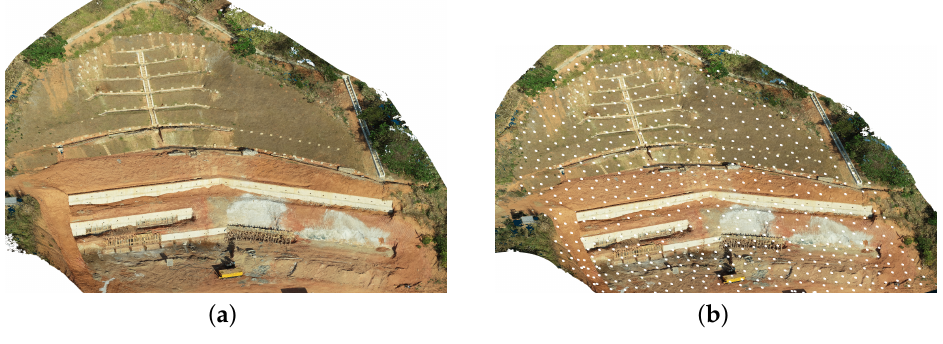
Figure 16. Inspection site: ( a ) 3D model; ( b ) waypoints.